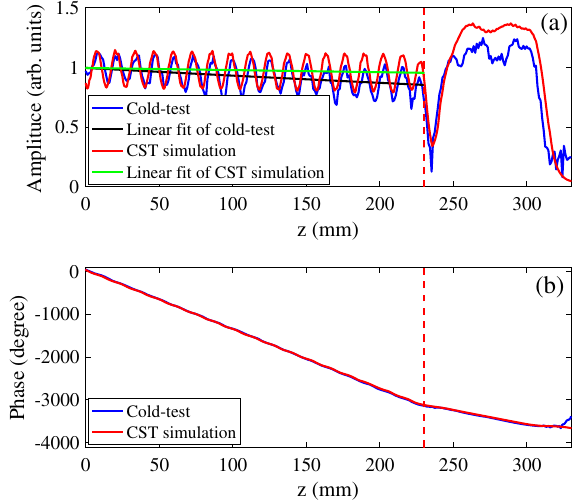
FIG. 11. Normalized amplitude (a) and phase (b) of the on-axis electric field in the dielectric-loaded power extractor at 11.7 GHz. Because the mode launcher was inserted into the dielectric tube, the field at the beam entrance could not be measured. The origin of the horizontal axis has been shifted accordingly. Vertical dashed lines indicate the boundary between the uniform section (left) and the tapered section/coupler